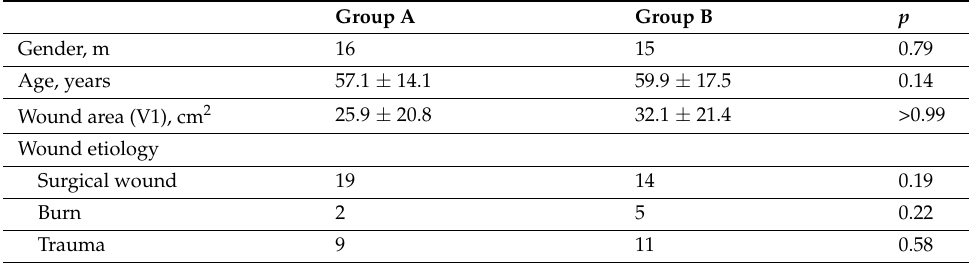
Group A, Connettivina ® Bio Plus; Group B, Fitostimoline ® Plus.